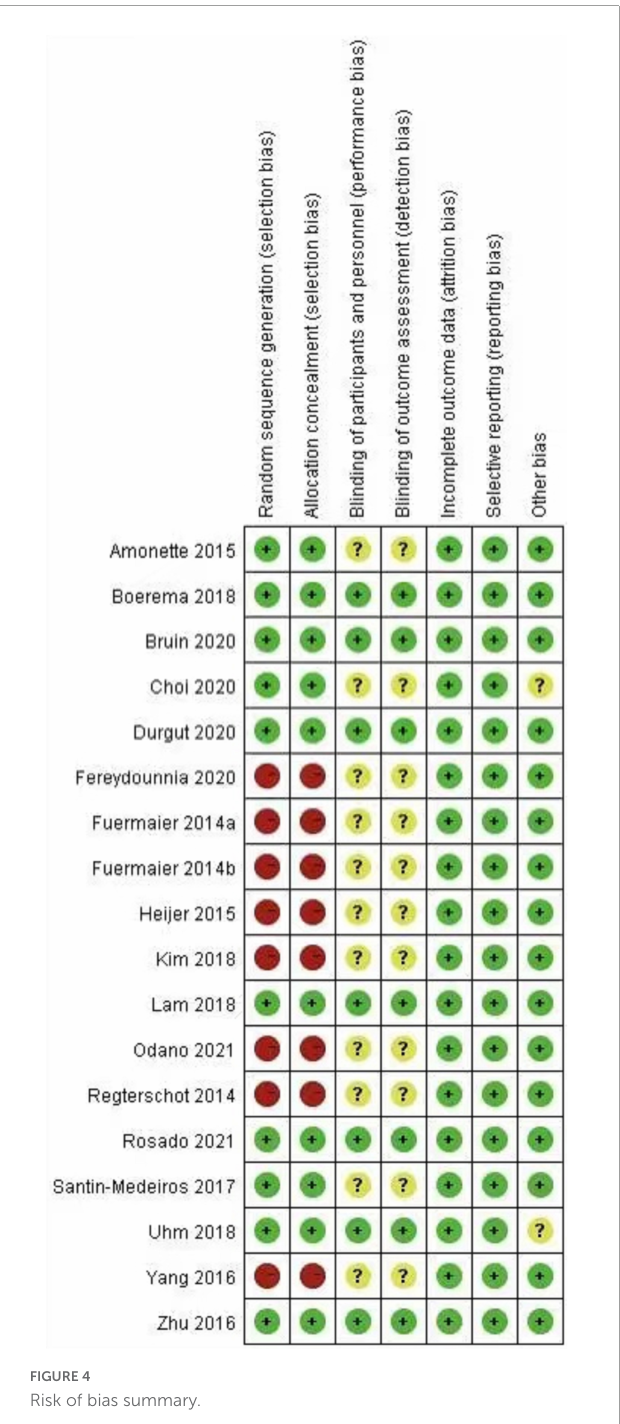
FIGURE4 Risk of bias